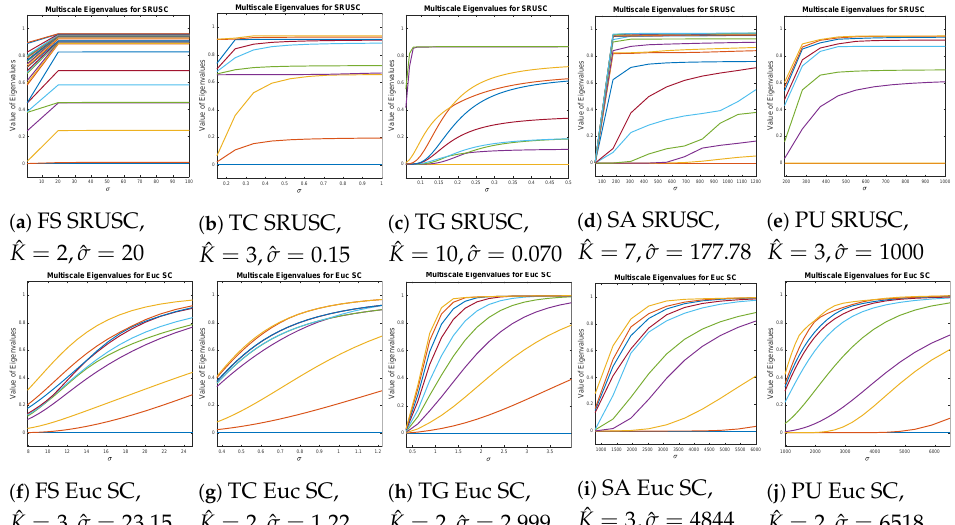
Figure 12. For each of the data sets, eigenvalues are shown as a function of σ . The ones on the top are the SRUSC eigenvalues ( a – e ), and on the bottom the Euclidean eigenvalues ( f – j ). The colors of the plots correspond to the eigenvalue index. The first eigenvalue is blue, and is always 0; the second eigenvalue is red, the third is yellow, the fourth is purple, the fifth is green, and so on. For a range of σ values, the largest gap for SRUSC is between the K th and ( K + 1 ) st eigenvalues for all three synthetic data sets, as well as Pavia U, indicating that SRUSC is correctly estimates K for these data. The proposed method estimates ˆ K = 7 for Salinas A, rather than K = 6, which is perhaps a reasonable misestimation given the complexity of the data and the fact that one of the classes is spectrally incoherent. On the other hand, the Euclidean eigenvalues completely fail to correctly estimate K , even on the synthetic